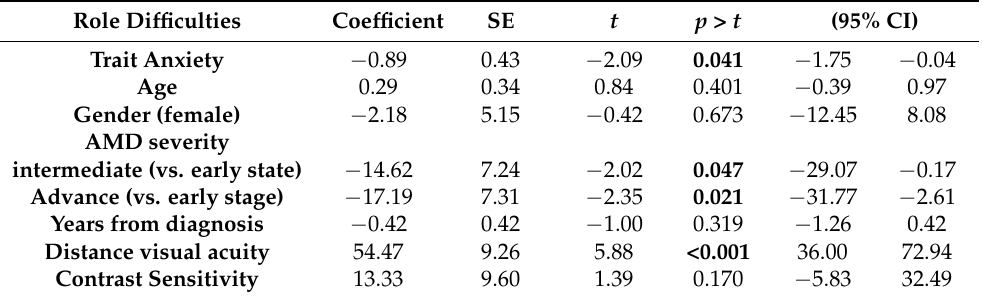
Table 7. Multiple linear regression model that correlates trait anxiety with the subscale Role Difficul- ties from the quality-of-life questionnaire